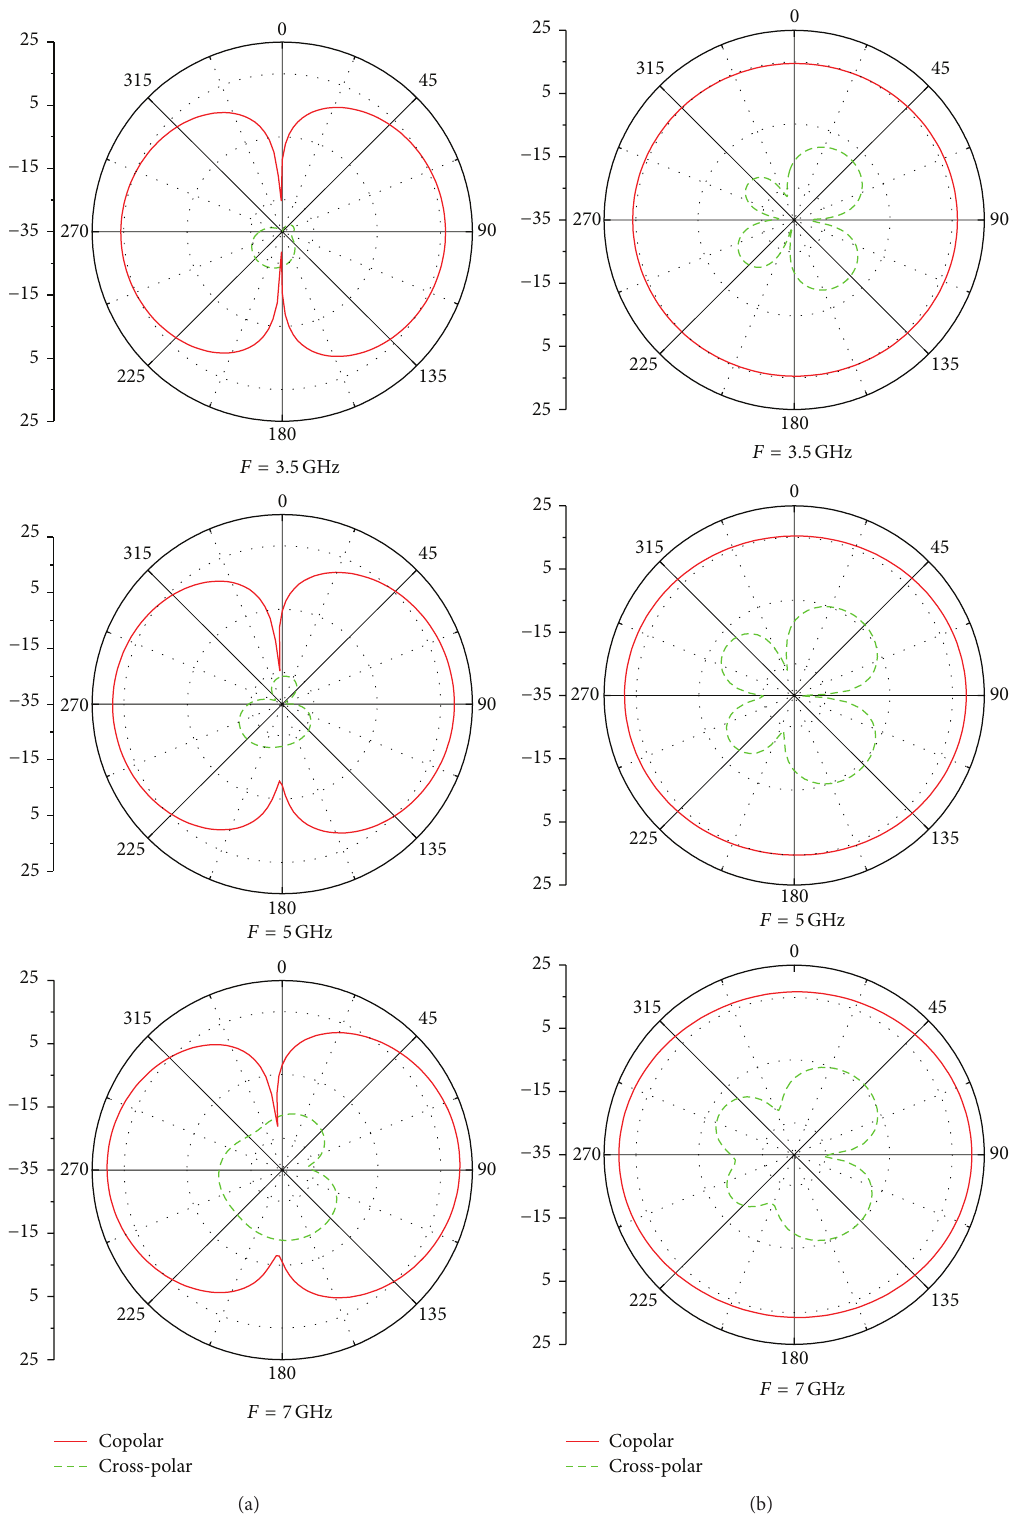
Figure 5: Simulated radiation patterns at (a) 𝑦𝑧 -plane and (b) 𝑥𝑦